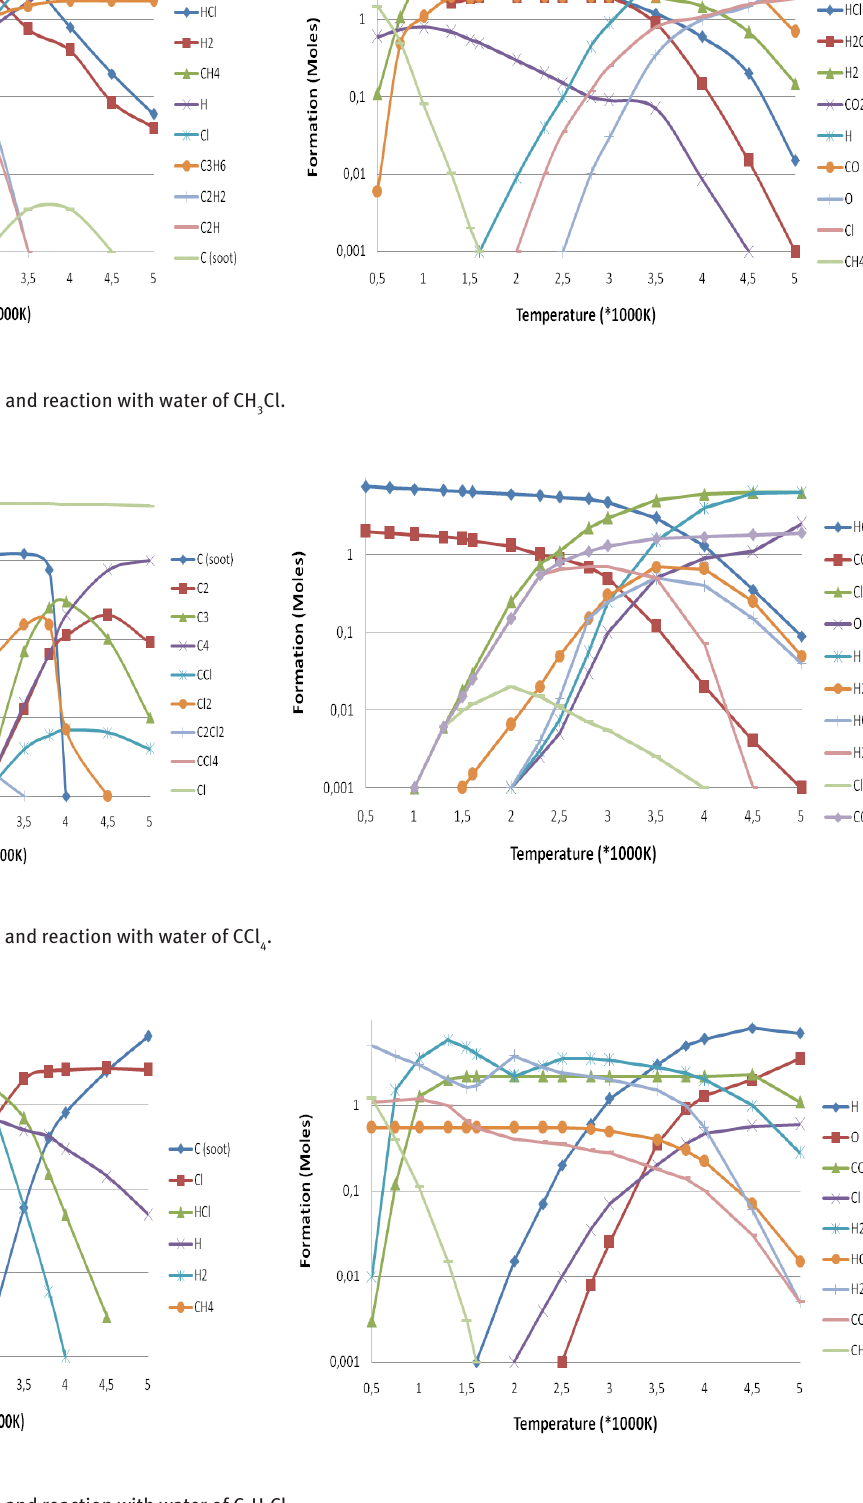
Figure 4 : Pyrolytical decomposition and reaction with water of C